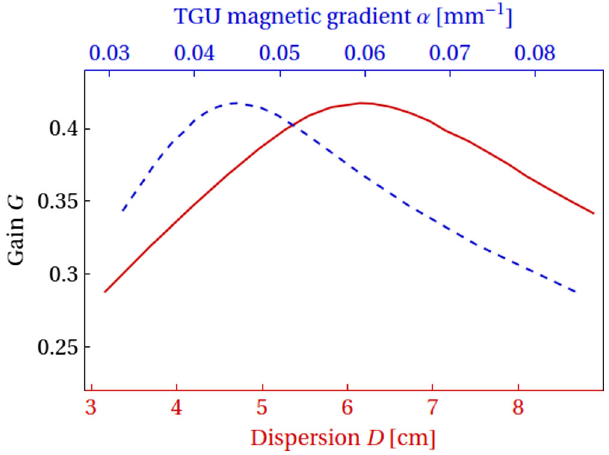
FIG. 4. Gain G versus electron beam dispersion D (red, solid) and TGU magnetic gradient α (blue, dashed) derived from numerical integration of the 3D gain formula. These parameters are derived from the TGU parameter Γ by Eqs. (6) and (7). Optimal gain is attained at D 0 . 045 mm − 1 for the chosen machine parameters.